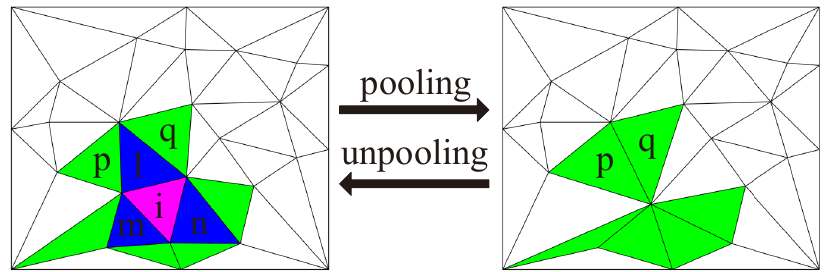
Figure 5. Pooling and unpooling. The purple part is the center face, which, together with the blue faces, makes up the pooling faces. Similar to the mesh simplification of face collapse, after pooling, they will